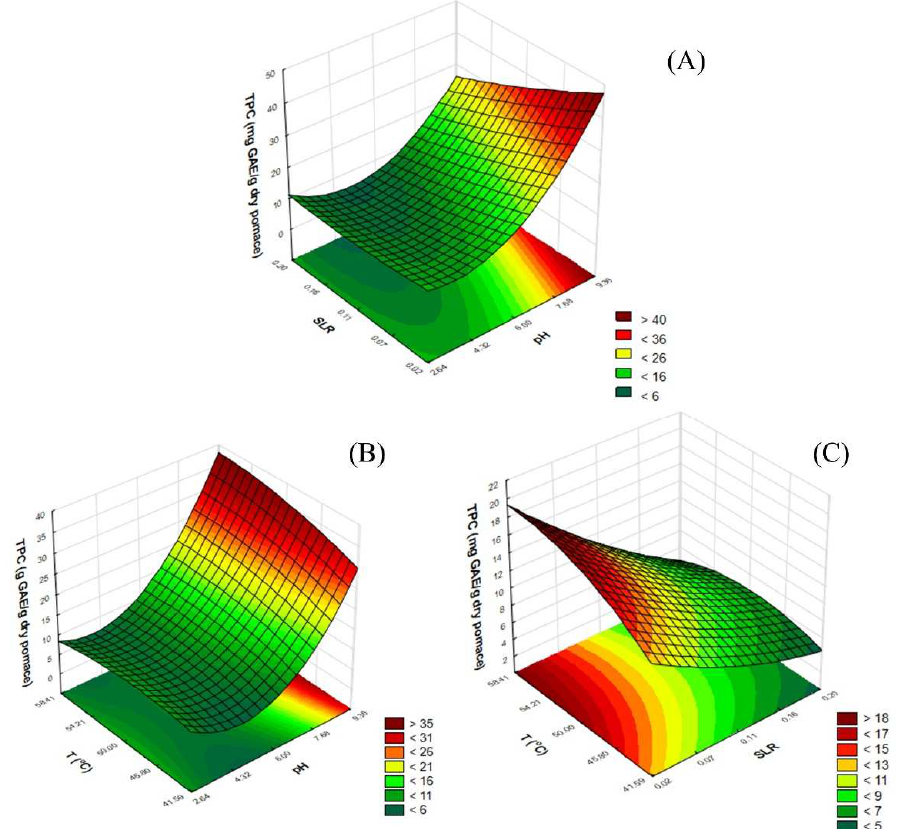
Figure 5. Response surface plot showing the effect of ( A ) SLR vs. pH, ( B ) Temperature ( ◦ C) vs. pH, and ( C ) Temperature ( ◦ C) vs. SLR on the TPC (Folin-Ciocalteu method) of grape pomace extracts in single-stage AEP after 75 min.